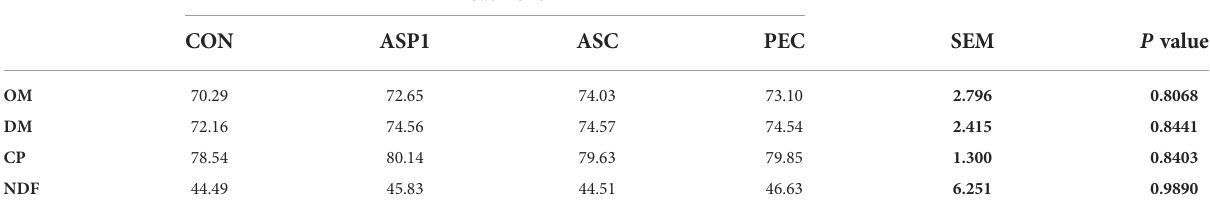
TABLE 3 Effect of seaweed inclusion on nutrient disappearances (Experiment 1) in the RUSITEC.